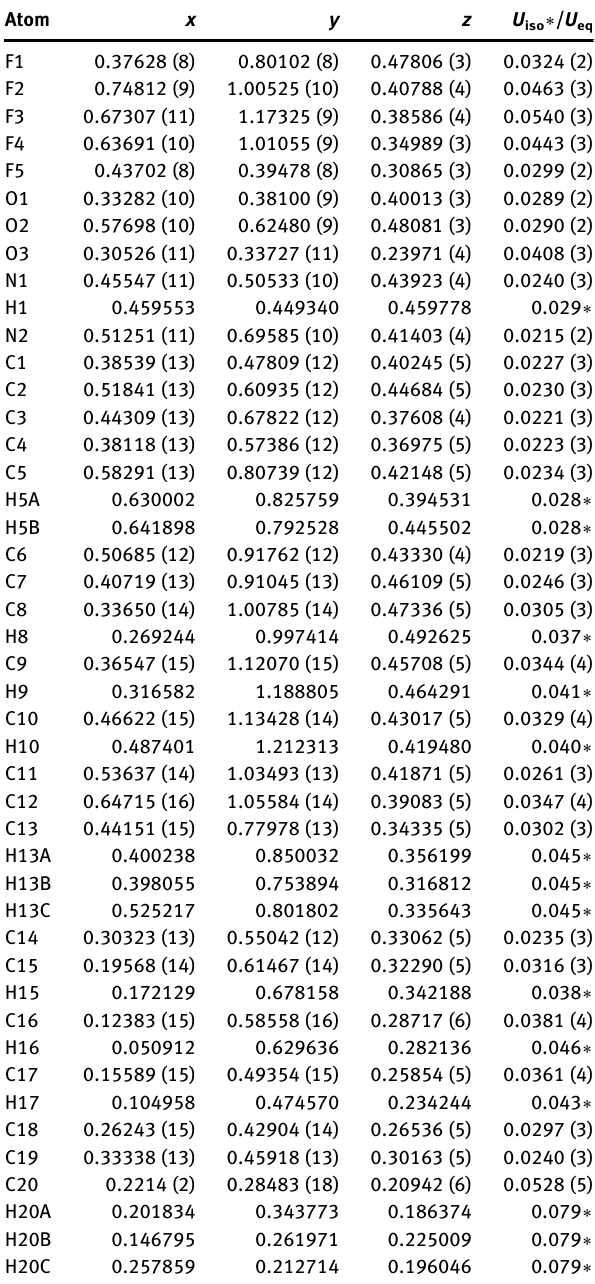
Table  : Fractional atomic coordinates and isotropic or equivalent isotropic displacement parameters (Å 